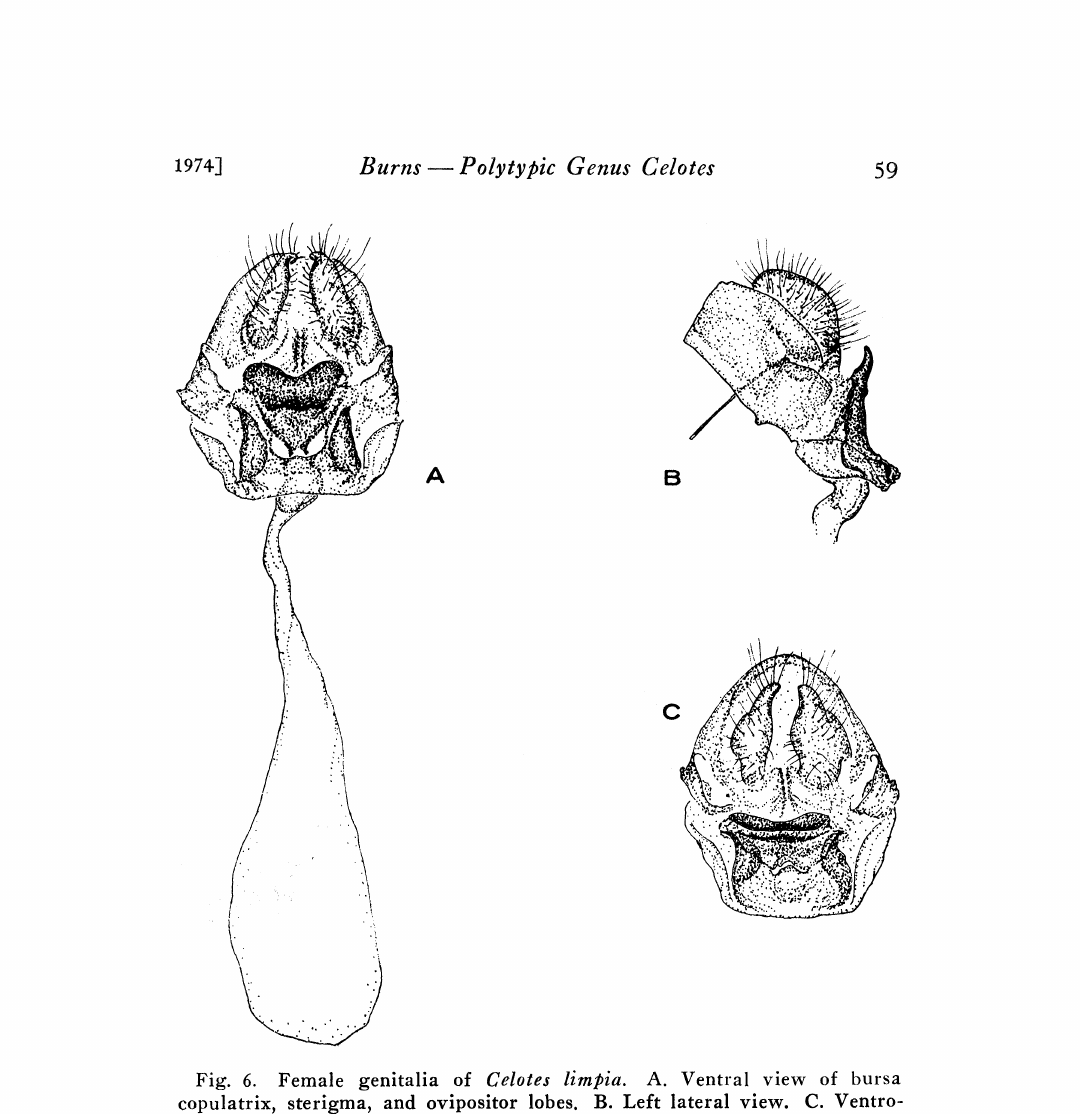
Fig. 6. Female genitalia of Celotes limpia. A. Ventral view of bursa copulatrix, sterigma, and ovipositor lobes. B. Left lateral view. C. Ventro- posterior view. [Drawn from paratype from Limpia Canyon, 4700 feet, Davis Mountains, mi. NE of Fort Davis, Jeff Davis County, Texas, V-4- 1959 (J. M. and S. N.